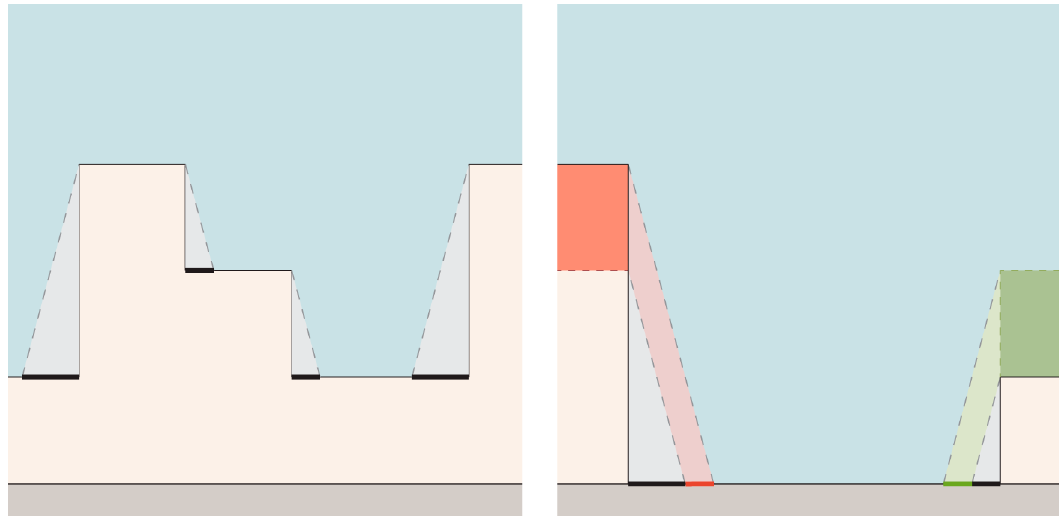
Figure 8. Projection of relative height onto lower volumes (left) and street (right).